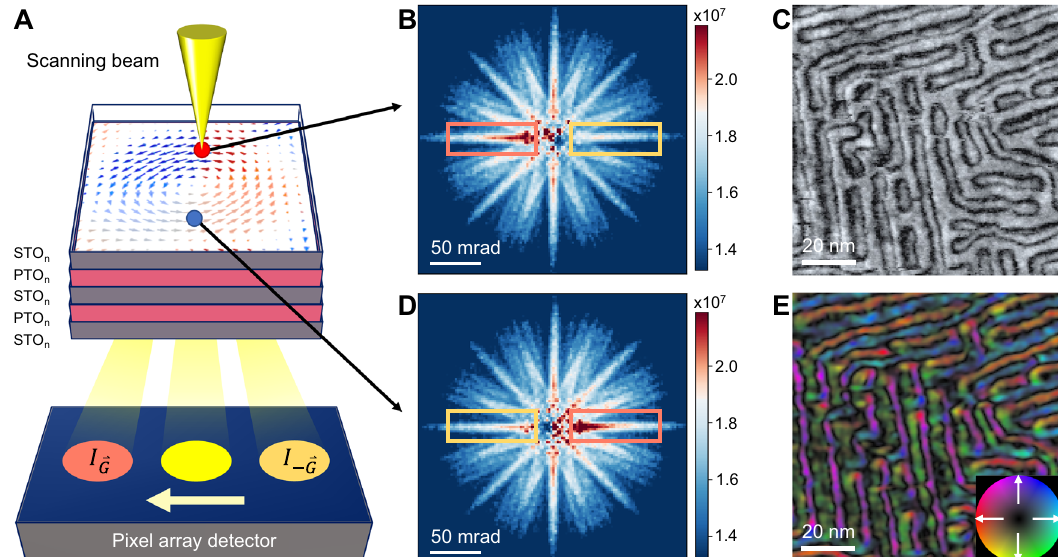
Fig. 2 | Imaging in-planepolarization textures. A Schematicof the plan-view 4D- STEM imaging technique on the [(PbTiO 3 ) 16 /(SrTiO 3 ) 16 ] 8 superlattice which uses a scanning electron probe and pixelated array detector, where a diffraction pattern was recorded at each probe position. The local polarization direction can be determinedby observing the difference ofdiffracted intensities of Friedel pairs, I and I .Representativediffractionpatternstakenfrom( B )topand( D )bottomofa (cid:3) G * skyrmion, where the polarity-sensitive Kikuchi bands in the thermal diffuse scat- tering are selected for determining polarization, as marked by pink and yellow